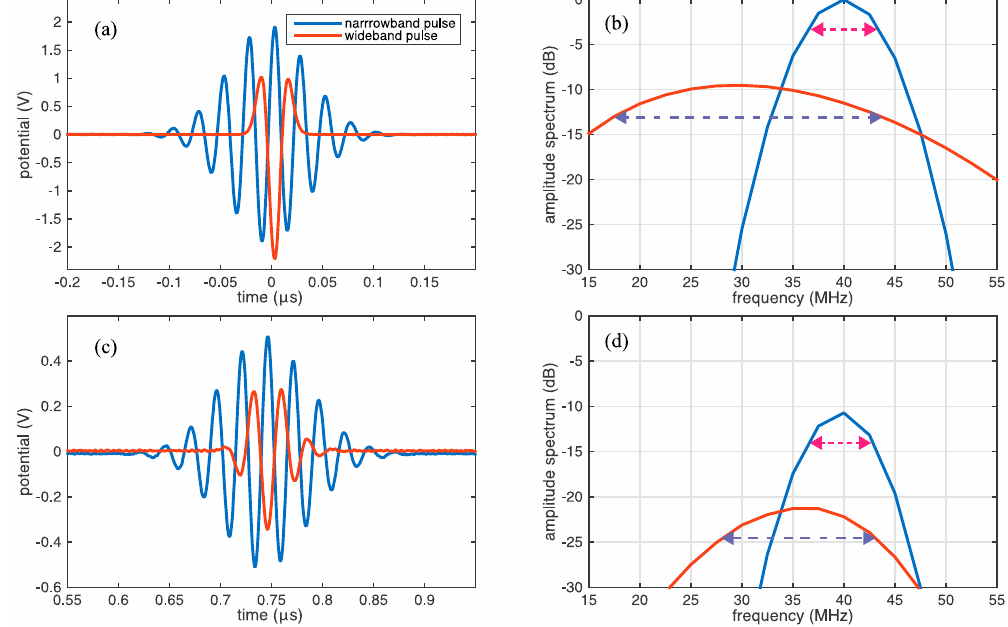
Figure 3. ( a ) Time-domain potential measurements for the narrowband and wideband pulses used to drive the transducer, and ( b ) their amplitude spectra. ( c , d ) Show the corresponding